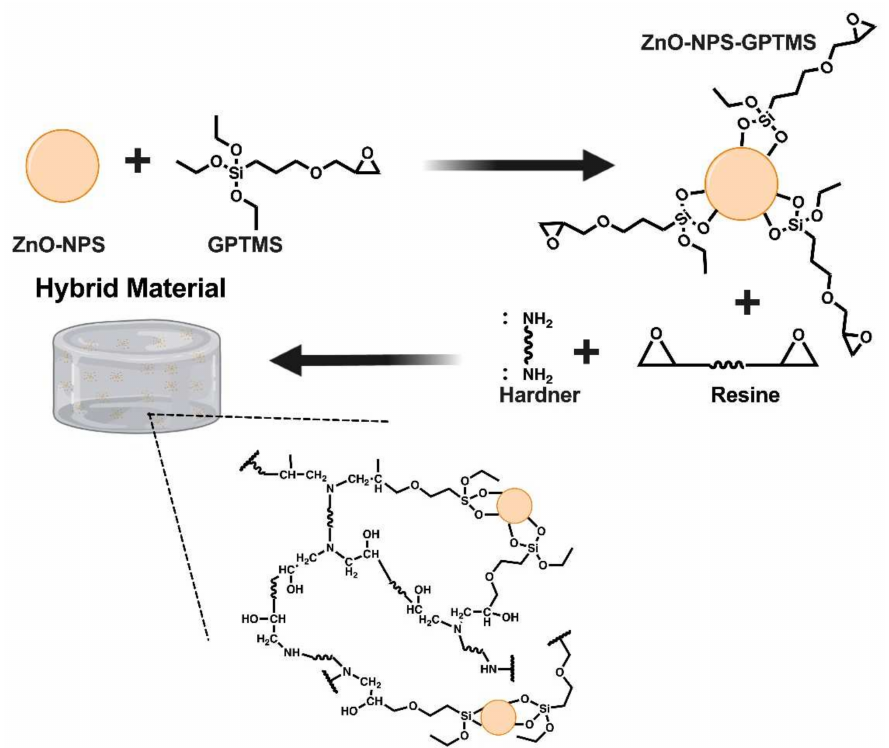
Figure 5. The invention relates to a mechanism for the synthesis of hybrid material by combining the epoxy resin and the ZnO-NPs-GPTMS to obtain the three-dimensional cross-linked network.